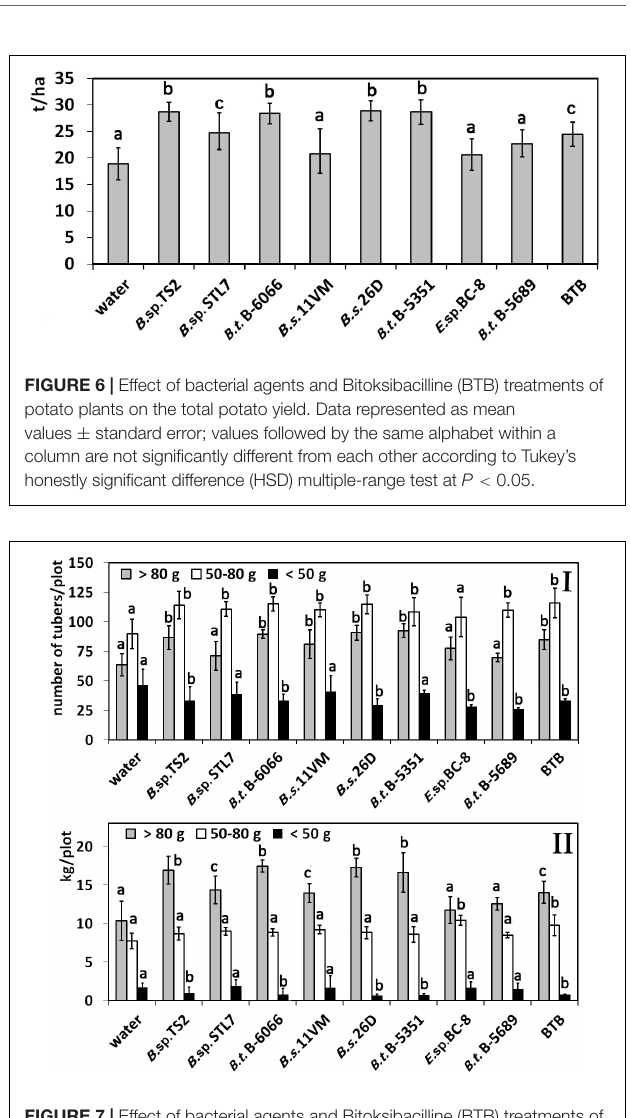
tubers in the fraction < 50 g under the influence of Bacillus